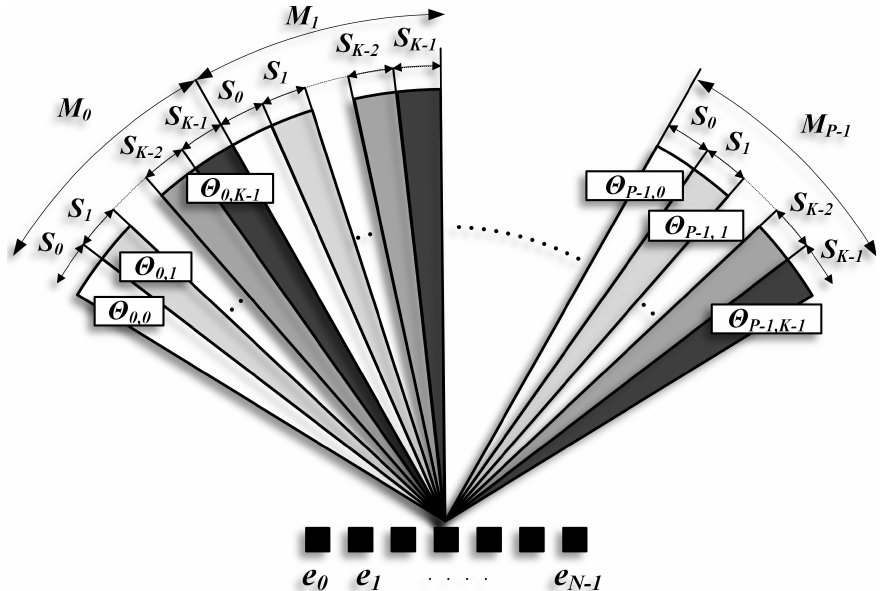
Figure 2. ePA (encoded phased array sectors). The scan area is divided into P sec sectors M , each one explored with K sequences S j =0 , 1 ,...,P − 1 directions Θ j,i =0 , 1 ,...,K − 1